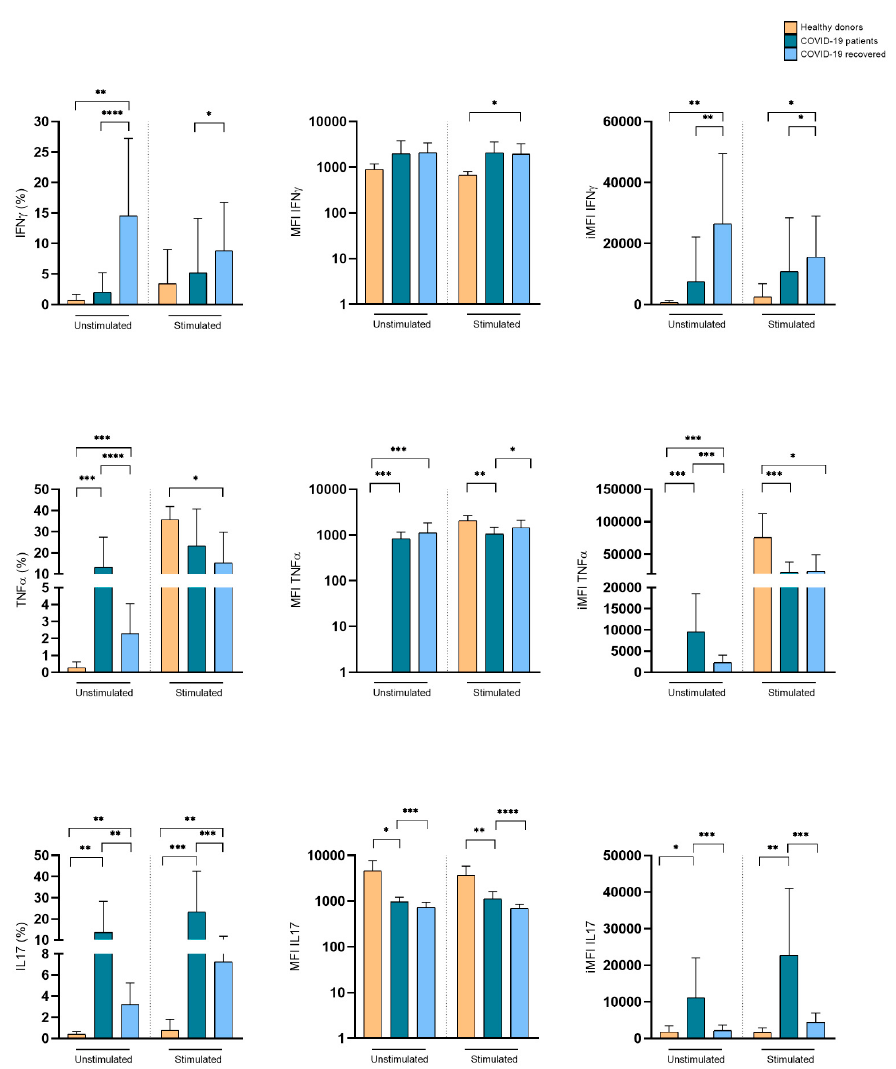
Figure 5. Expression of pro-inflammatory cytokines by V δ 2+ T lymphocytes in hospitalized and recovered COVID-19 patients, compared to healthy subjects. Cumulative histograms representing the expression of pro-inflammatory cytokines. Shown are percentage ( left panels ), MFI ( central panel , log 10 scale), and iMFI ( right panels ) ± SD. * p < 0.05, ** p < 0.01, *** p < 0.001, and **** p < 0.0001.